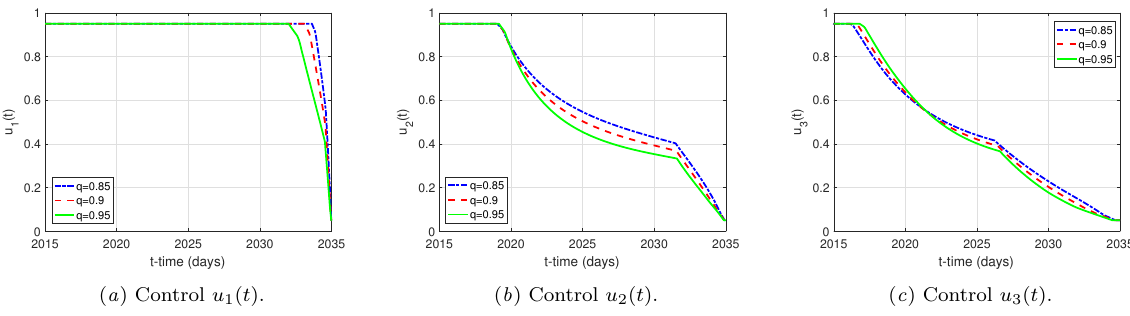
Figure 3. Case C 123 : Optimal controls u 1 ( t ) , u 2 ( t ) and u 3 ( t